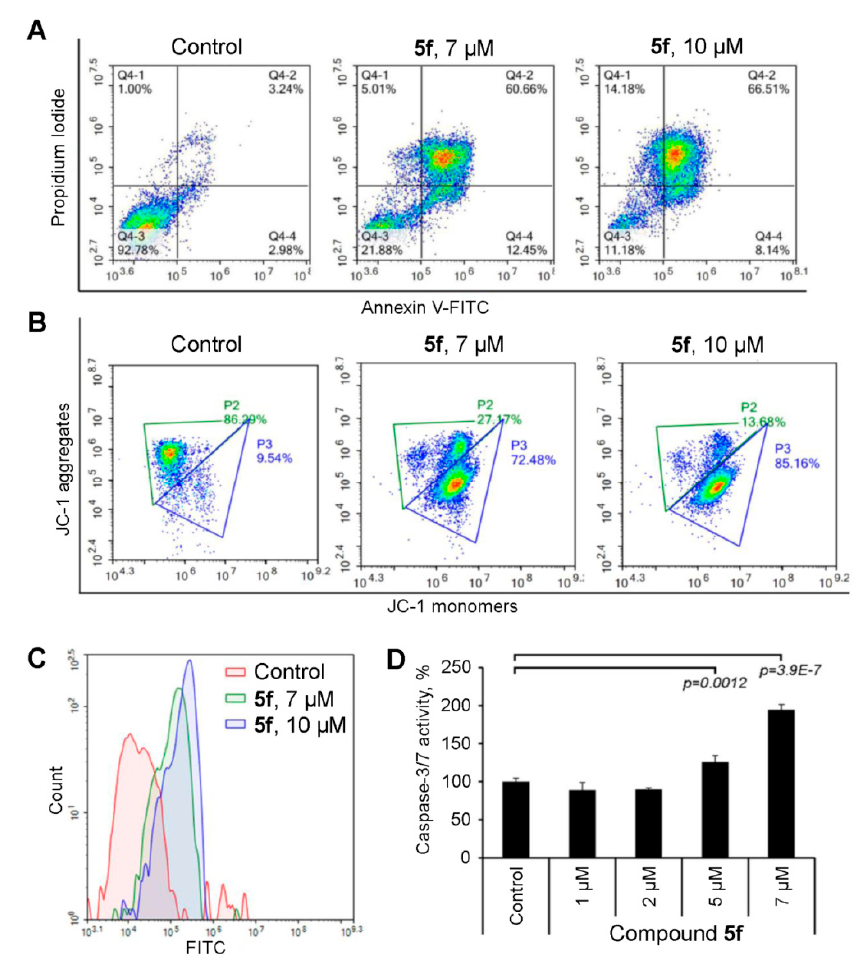
Figure 3. Compound 5f induces mitochondrial caspase-dependent apoptosis in HeLa cells. ( A ) Compound 5f causes externalization of phosphatidylserine. HeLa cells were treated by 5f at indicated concentrations for 48 h, stained by annexin V-fluorescein isothiocyanate (annexin V FITC) / propidium iodide (PI), and analyzed by flow cytometry. ( B ) Compound 5f stimulates the dissipation of mitochondrial membrane potential in HeLa cells. Tumor cells were treated by 5f as in ( A ), followed by staining of cells with JC-1 and flow cytometry analysis. ( C ) Compound 5f activates the caspase cascade. HeLa cells were treated by 5f similarly to ( A ), followed by labeling of active caspases by fluorescein isothiocyanate (FITC) conjugate of the cell-permeable pancaspase inhibitor VAD-FMK (FITC-VAD-FMK) and flow cytometry analysis. ( D ) Compound 5f increases the activity of executioner caspases-3 / 7. HeLa cells were treated by 5f at indicated concentrations for 48 h followed, by measurement of the levels of activity for caspases-3 / 7 using a Caspase-Glo ® 3 / 7 Assay kit (Promega, Madison, WI,